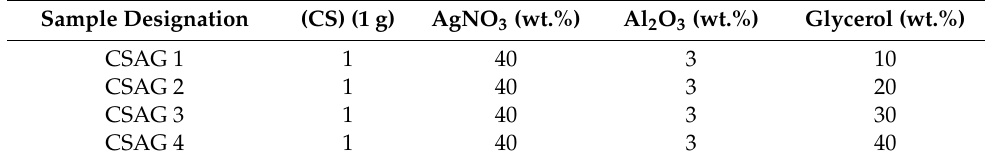
Table 1. The composition of chitosan (CS)–AgNO 3 –Al 2 O 3 –glycerol